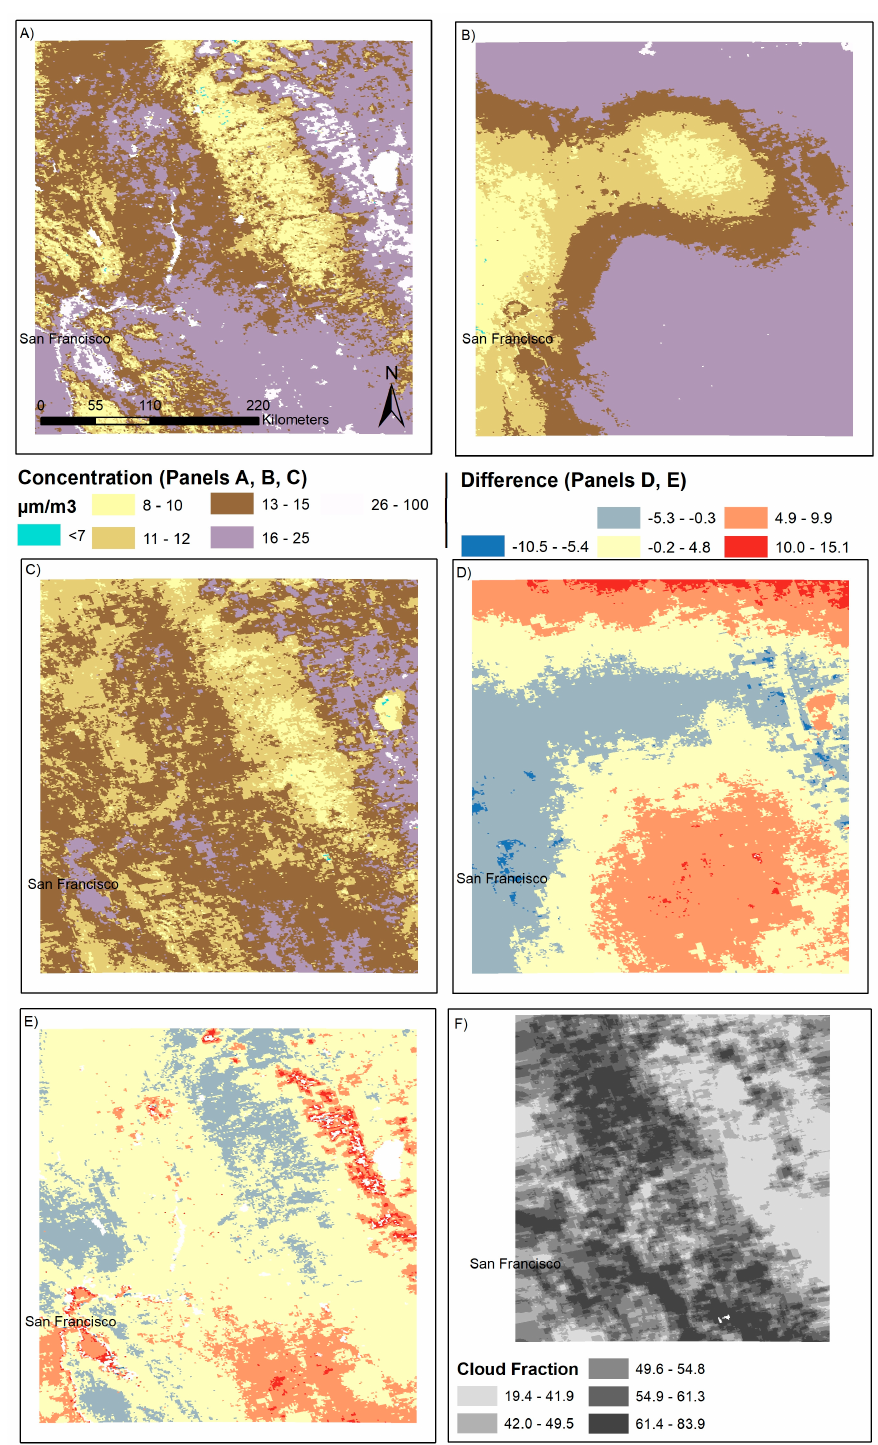
Figure 3. Case study results in San Francisco for January 2012. Results presented are mean concentrations in µ g/m 3 over the month of January for: ( A ) un-gap-filled surface (Equation (2)); ( B ) Harvard model gap-filled surface (Equations (2) and (3)); ( C ) Cloud gap-filled surface (Equations (1) and (2)); ( D ) the difference between the Harvard gap-filled and Cloud gap-filled results at the monthly level; ( E ) the difference between the ungap-filled and Cloud gap-filled results at the monthly level; and ( F ) the fraction of days with a water or ice cloud, as detected by the MODIS M*D06 cloud product.